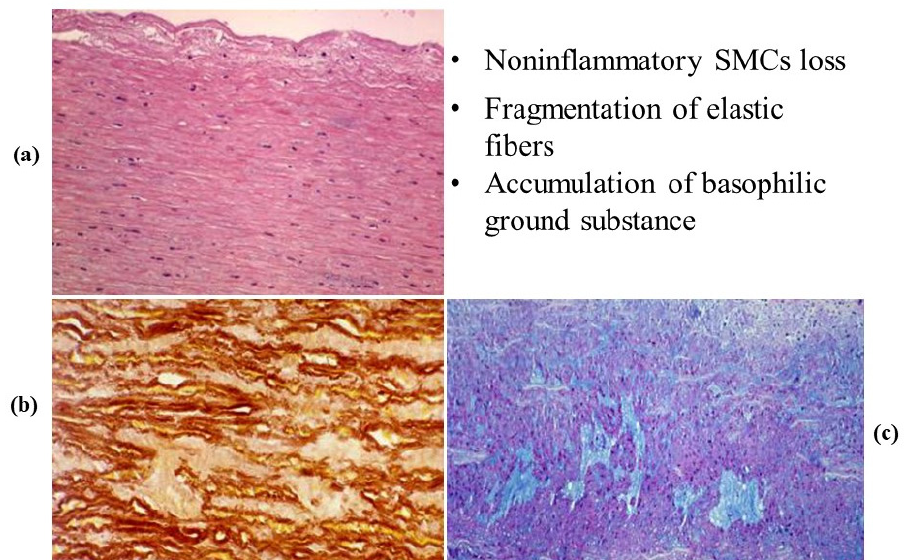
Figure 15. Elementary degenerative lesions in the tunica media of the aorta. ( a ) Non-inflammation loss (medionecrosis) of smooth muscle cells (SMCs). ( b ) Elastic fragmentation. ( c ) Cystic medial necrosis. (Hematoxylin-eosin ( a ), Weigert Van Gieson ( b ), and Alcian PAS ( c ) stains).